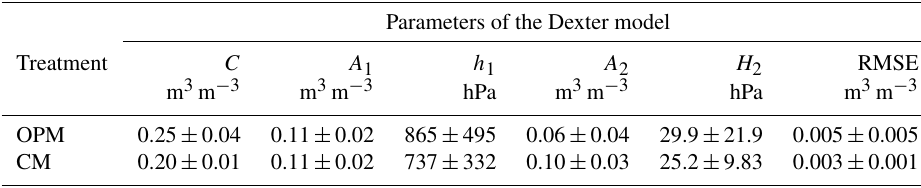
Table 4. Average values of the fitted parameters of the double-exponential water retention equation by Dexter et al. (2008) obtained with the experimental dataset. Mean ± standard deviation of the mean ( n = 3). All the differences are not statistically significant ( p > 0 .